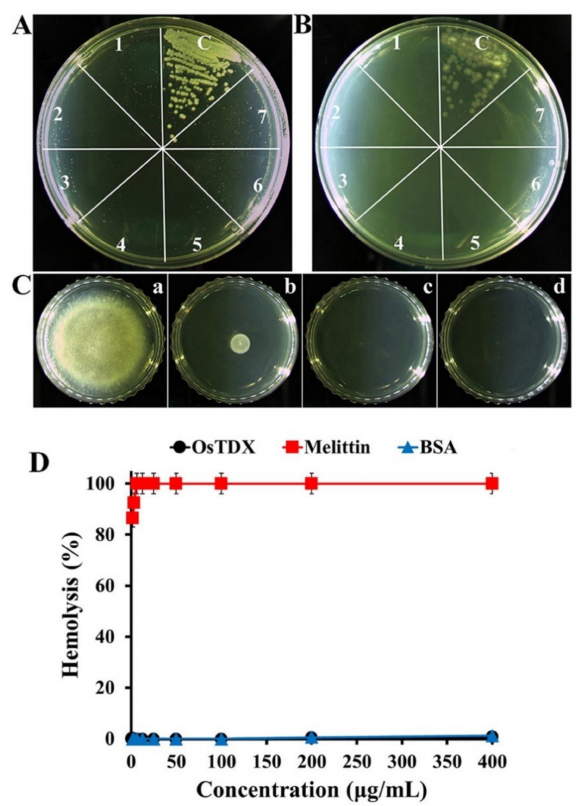
Figure 3. Antifungal activity of OsTDX protein against Candida albicans ( A ), Candida krusei ( B ), or Colletotrichum gloeosporioides ( C ) and cytotoxic effect of OsTDX, melittin, or BSA proteins against rat erythrocytes ( D ). ( A , B ) After 24-h incubation of fungal cells, in the presence of OsTDX, at the indicated concentrations, the cells were further incubated on agar medium for 24 h; c: control, 1: 200 µ g/mL, 2: 100 µ g/mL, 3: 50 µ g/mL, 4: 25 µ g/mL, 5: 12.5 µ g/mL, 6: 6.25 µ g/mL, 7: 3.13 µ g/mL. ( C ) C. gloeosporioides conidia cells incubated with OsTDX protein for 24 h were dropped onto agar medium and further incubated for 72 h; a: control, b: 50 µ g/mL, c: 100 µ g/mL, d: 200 µ g/mL. ( D ) After 2 h incubation of rat erythrocytes (8%, v / v ) in the presence of proteins, the released hemoglobin was measured at 414